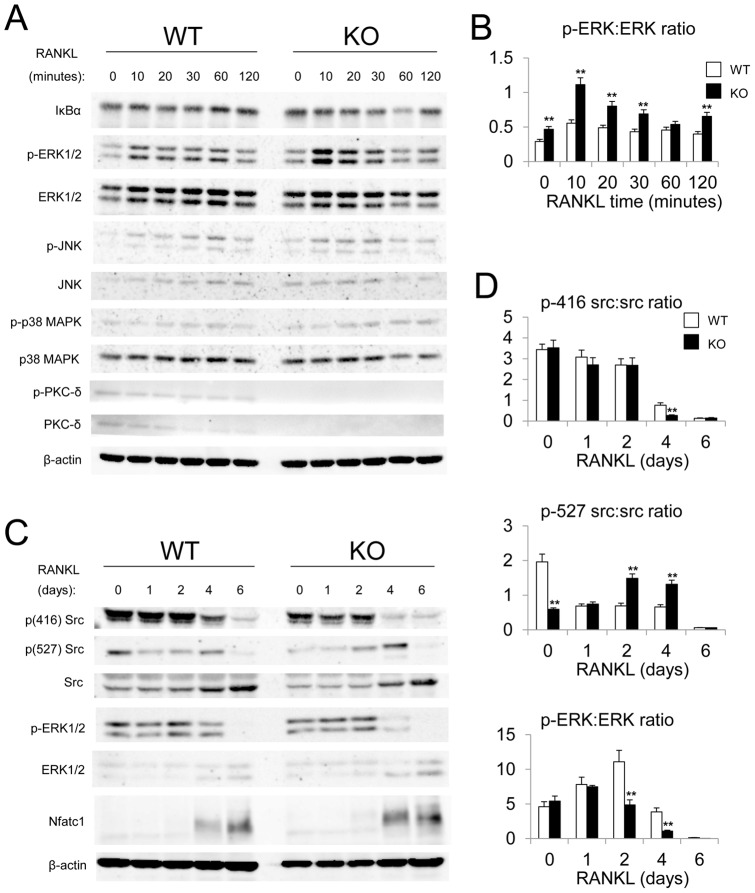
Altered ERK and Src signaling in PKC-δ deficient osteoclasts.WT and PKC-δ KO BMMs were serum-starved overnight before stimulation with M-CSF and 100 ng/ml of RANKL at the indicated times. (A) Western blot analysis of total protein from WT and PKC-δ KO BMMs stimulated with M-CSF and 100 ng/ml of RANKL (short time-course, 0–120 min). (B) Quantitative analysis of short-term ERK phosphorylation relative to total ERK protein expression by densitometry of western blot images. (C) Western blot analysis of RANKL-induced osteoclastogenesis (long time-course, 0–6 days). (D) Quantitative analysis of Src Tyr-416 and Tyr-527 phosphorylation status relative to total Src protein expression, and long-term ERK phosphorylation relative to total ERK protein expression, as measured by densitometry of western blot images. β-actin was probed as a loading control. Statistical analysis was performed by comparing to WT in each time point. *, p-value <0.05. **, p-value<0.01.